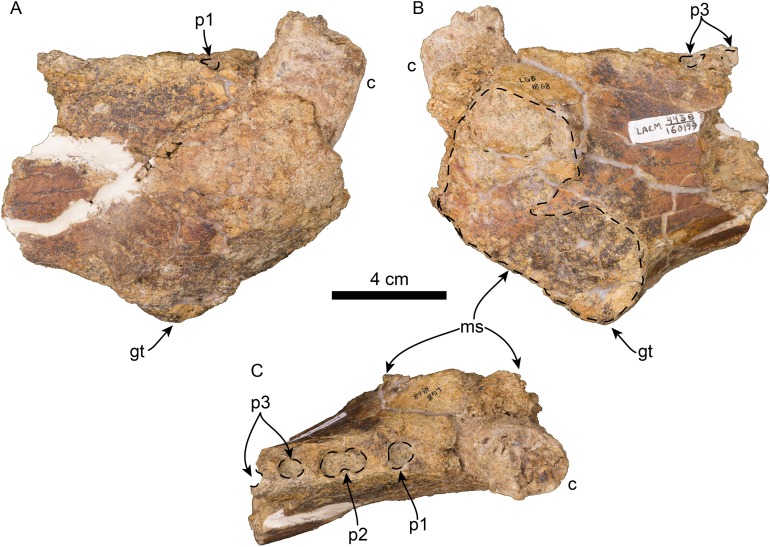
Referred partial mandible of Titanotaria orangensis n. gen. et sp. (LACM 160199).Left mandible in lateral (A), medial (B), and occlusal (C), views. Abbreviations: c, lower canine; gt, genial tuberosity; p1–3, lower premolars 1–3; ms, mandibular symphysis.